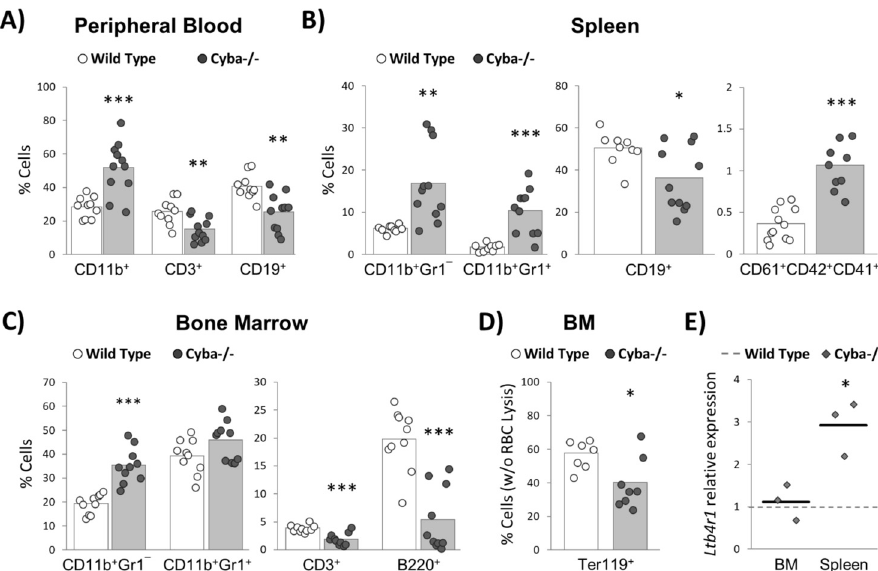
Figure 3. Changes in mature haematopoietic lineages in granuloma-bearing Cyba − / − mice. Per- centage of haematopoietic populations in peripheral blood (PB) ( A ), spleen ( B ) and bone marrow (BM) ( C , D ) of Cyba − / − and control mice. CD11b + : myeloid populations; CD11b + Gr1 − : monocytic populations; CD11b + Gr1 + : granulocytic populations; CD3 + : T-lymphocytes; CD19 + and B220 + : B-lymphocytes; CD61 + CD42 + CD41 + : megakaryocytes; Ter119 + : erythroid populations. ( E ) Relative expression of the Ltb4r1 gene in the BM and spleen of Cyba − / − (diamond dots) mice with respect to control mice (discontinuous line), analysed by qRT-PCR. Black lines represent the group mean. * p < 0.05, ** p < 0.01, *** p <